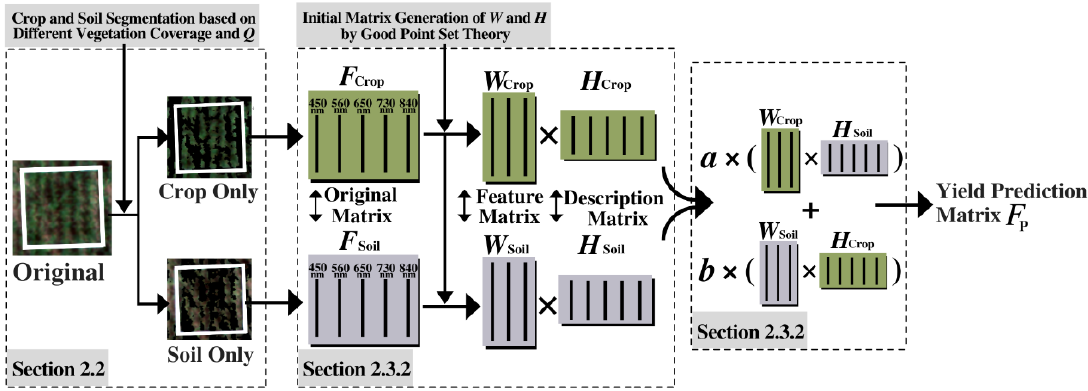
Figure 2. Flow chart of PNM-MCF.